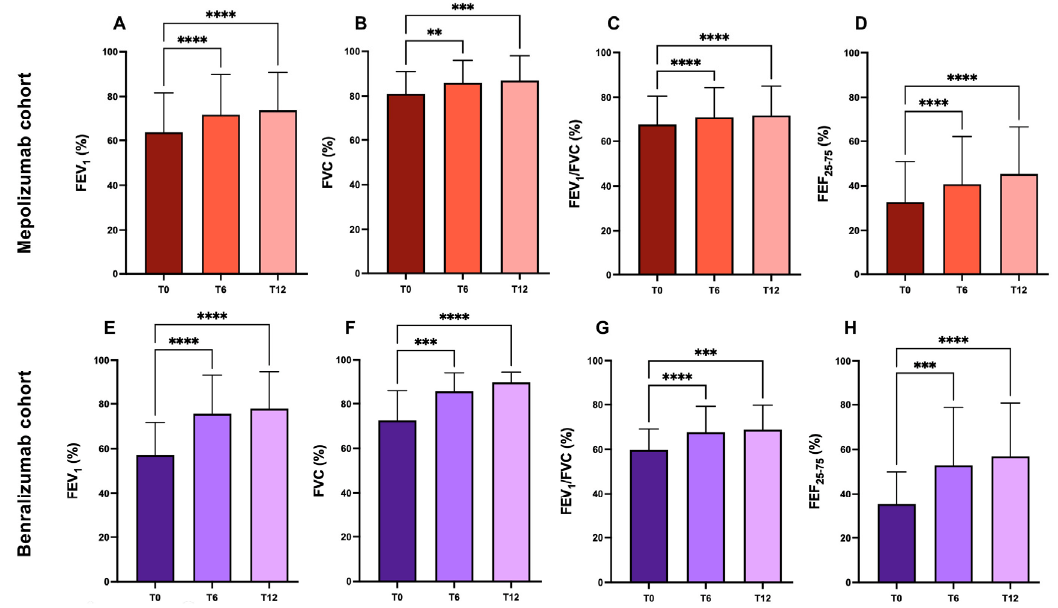
Figure 2. Improvements in lung function parameters after treatment with biologics. Panels (( A – D